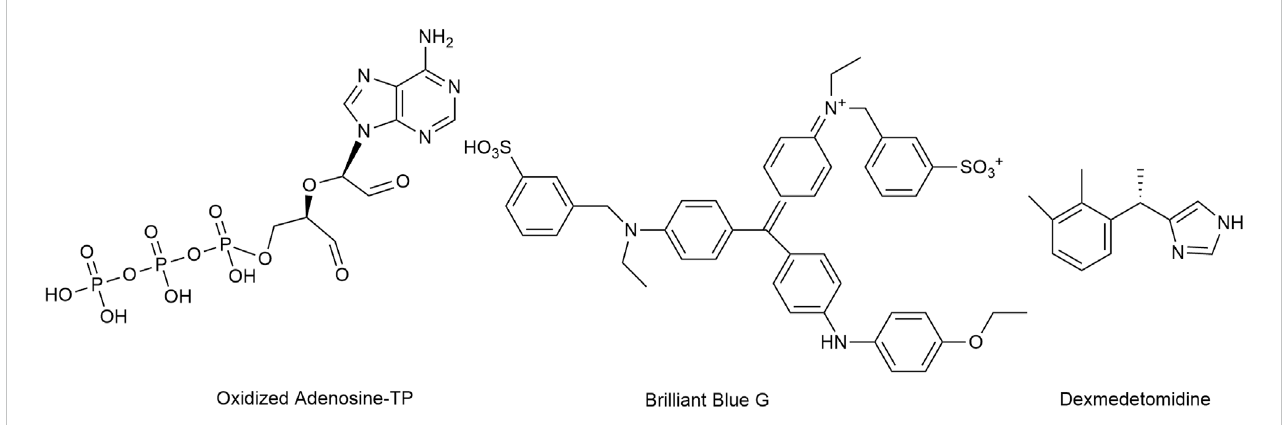
FIGURE 9 The structures of oxidized Adenosine-TP, Brilliant Blue G and dexmedetomidine, which mediate the inhibition of P2X7